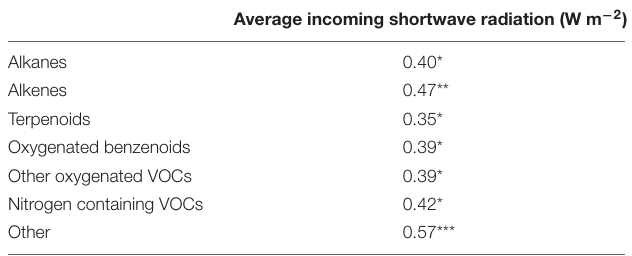
TABLE 2 | Pearson’s correlation coefficients between emission rates ( µ g m − 2 h − 1 ) from bare ice surfaces ( n = 31) per compound class and incoming shortwave radiation averaged during sample collection.